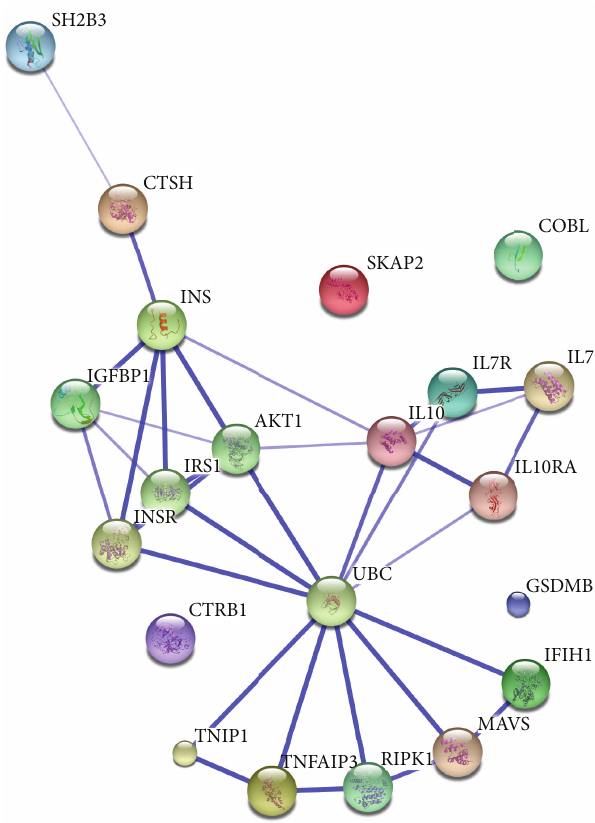
Figure 3: Protein interaction network of the 11 genes. The network was constructed using the STRING tool (http://string-db.org) and the 11 candidate genes as input. The width of the interactions depends on the confidence score to each association in